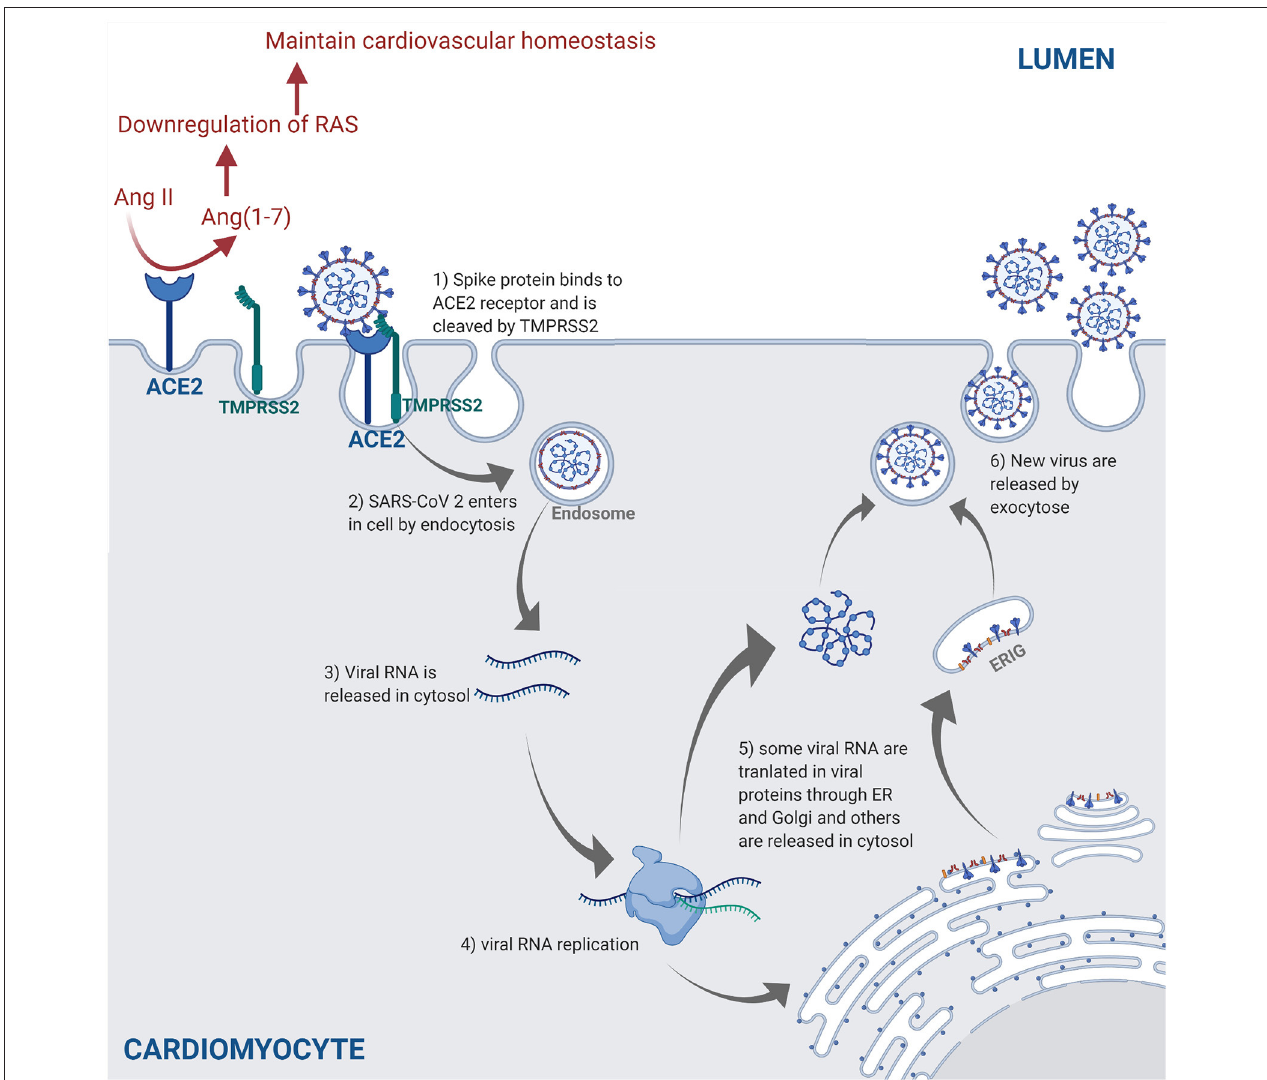
FIGURE 2 | The SARS-CoV-2 pathway in the host cells. The spike protein of the virus binds to the cellular receptor angiotensin-converting enzyme 2 (ACE2) and is cleaved by the type 2 transmembrane serine protease (TMPRSS2). This allows entry into the host cell by endocytosis. Following the entry of SARS-CoV-2, viral RNA is released into the cytoplasm and replicated. Viral RNA is translated by the endoplasmic reticulum (ER) by Golgi complex and form the endoplasmic reticulum–Golgi intermediate compartment (ERIG). Viral RNA enters into ERIG by budding to form novel virions. These virions are released from the infected cells by exocytosis. The ACE2 receptor is a negative regulator of the renin angiotensin system (RAS) and converts angiotensin II (Ang II) into angiotensin 1–7 [Ang(1–7)]. The downregulation of the RAS allows to maintain the cardiovascular homeostasis (figure created with